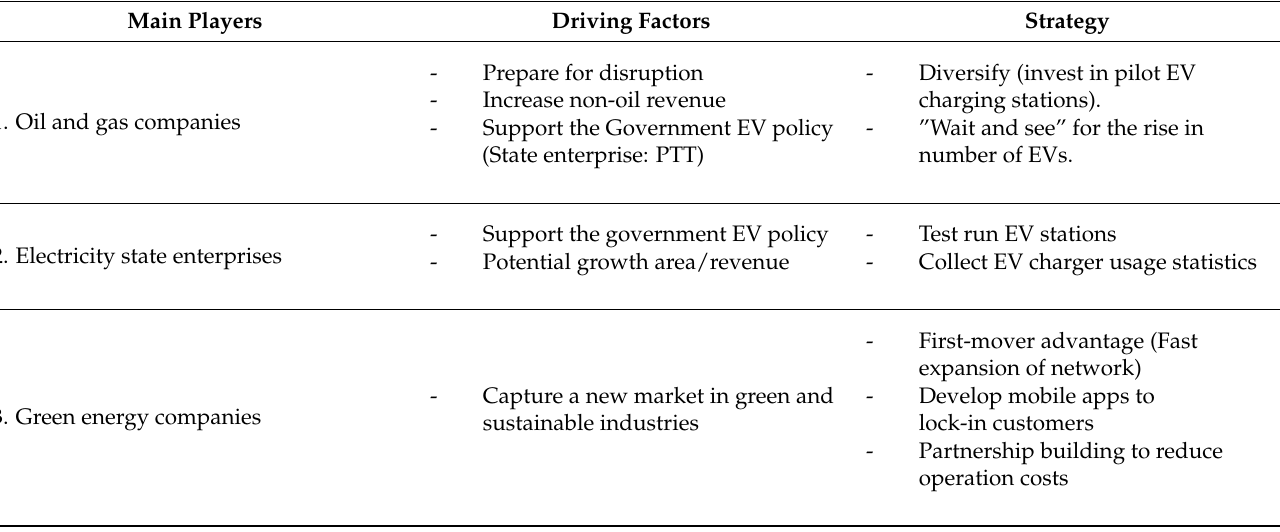
Table 9. Driving factors and strategy of main players in the EV charging business. Main